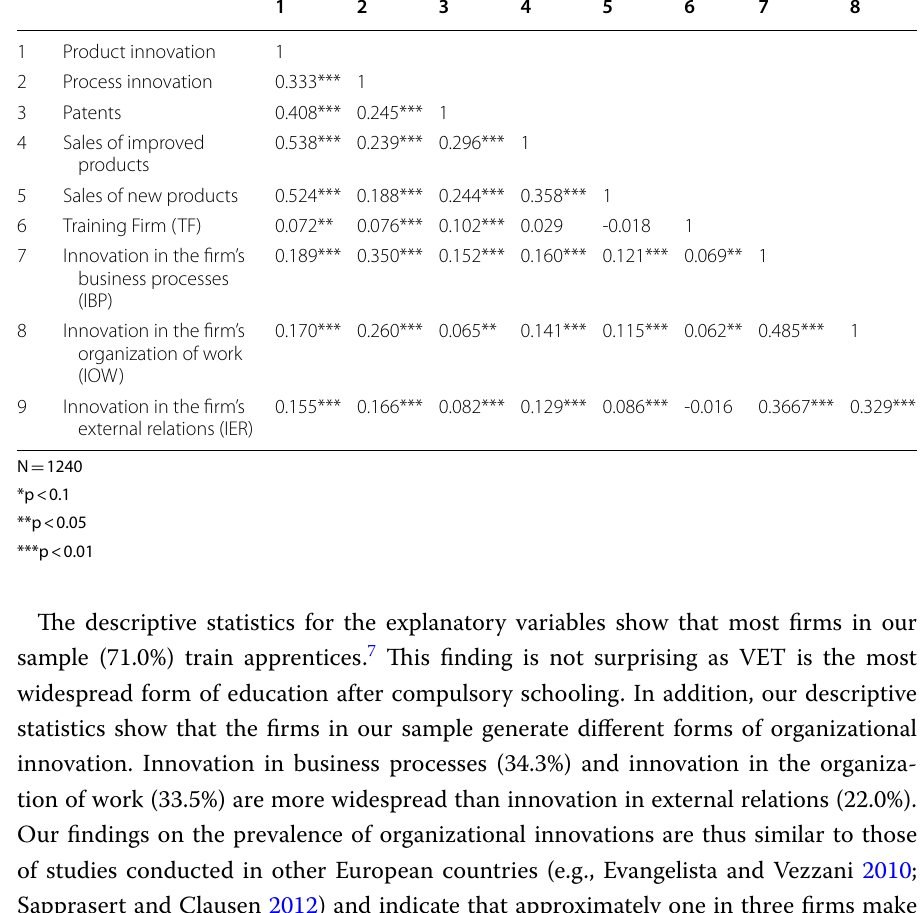
Table 2 Correlation table of outcome and main explanatory variables